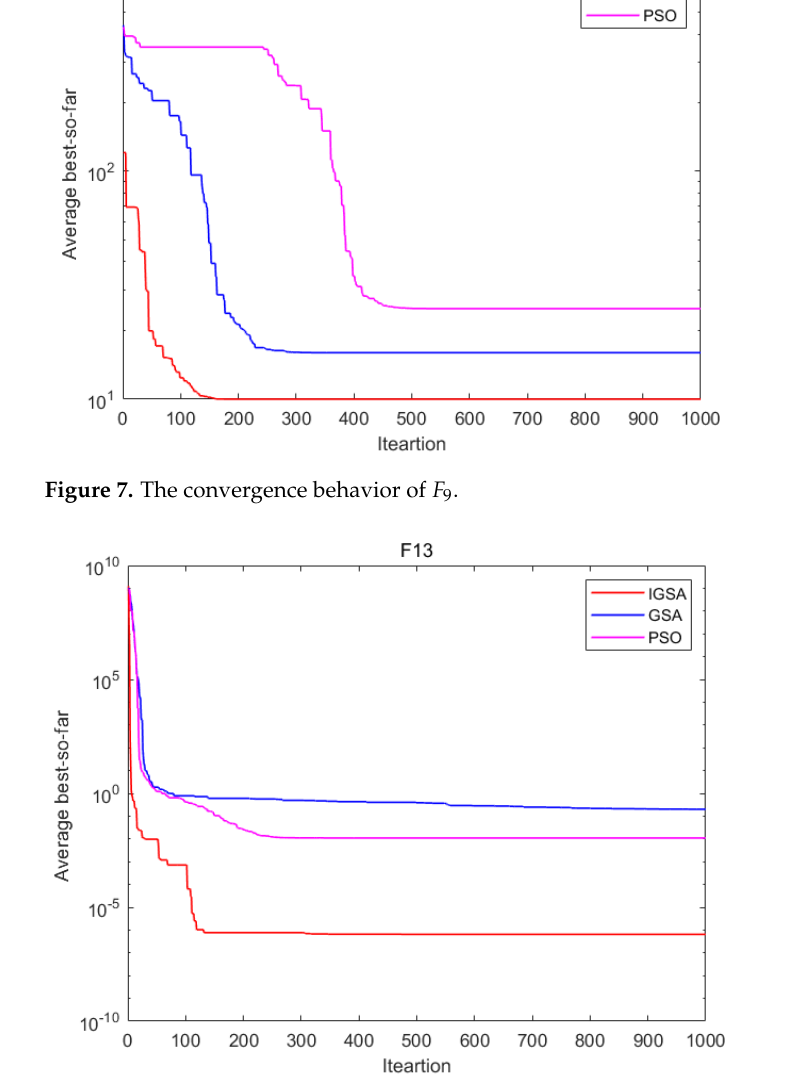
Figure 8. The convergence behavior of F 13